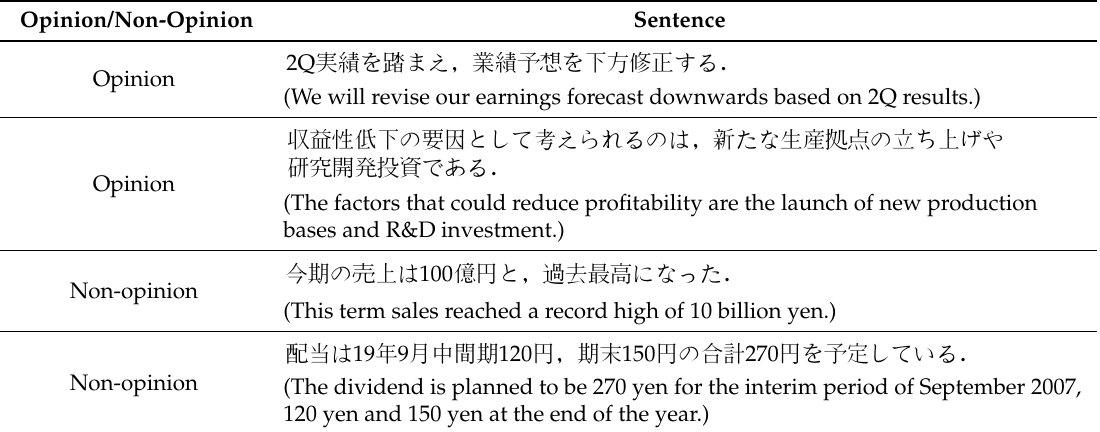
Table 2. Typical examples of opinion and non-opinion sentences in analyst reports. English follows Japanese.